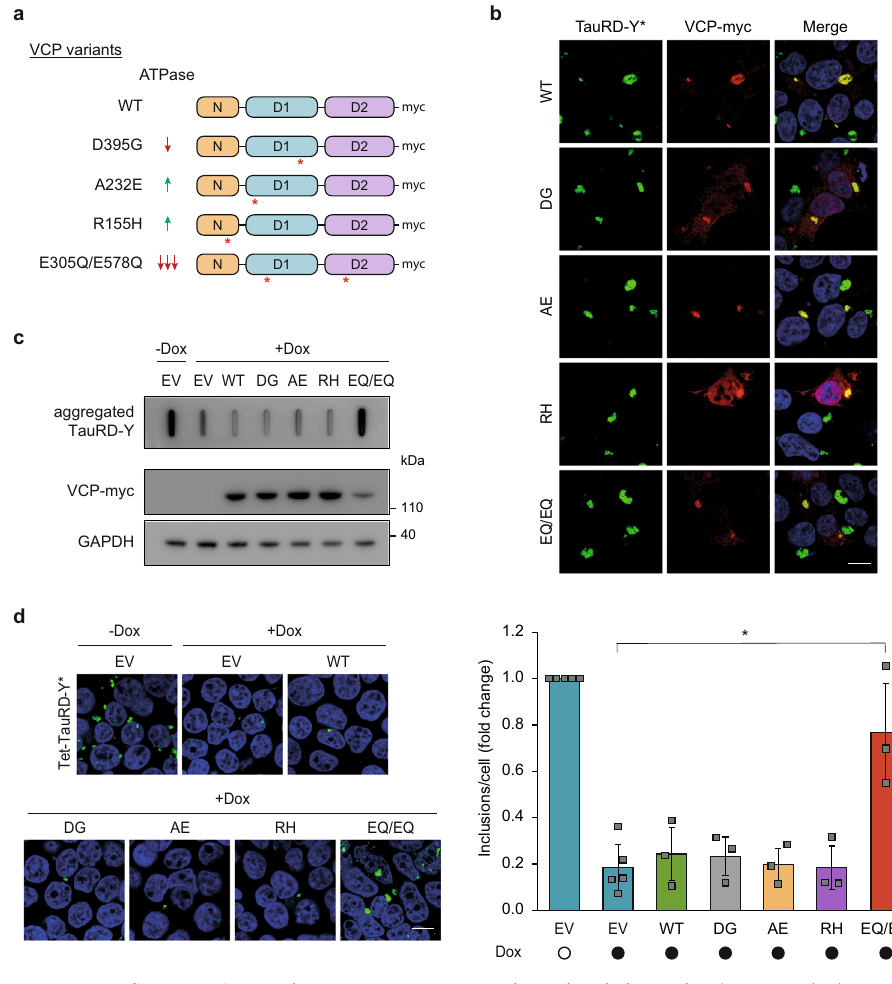
Fig. 5 | Effects of VCP mutants on Tau disaggregation. a Schematic representa- tion of VCP variants used in this study. Wild type (WT), D395G (DG), A232E (AE), R155H(RH)andE305Q/E578Q(EQ/EQ)VCPweretaggedwithaC-terminalmyc-tag. Red asterisks indicate relative positions of the mutations. b Association of tran- siently expressed VCP variants with TauRD-Y inclusions. Immuno fl uorescence staining of myc (red) and YFP fl uorescence of TauRD-Y (green) in TauRD-Y* cells. Representative images from two independent experiments are shown. Scale bar, 10 µ m. c Filter trap analysis of lysates from Tet-TauRD-Y* cells transiently trans- fected with empty vector (EV) or indicated VCP variants for 24h, and treated for